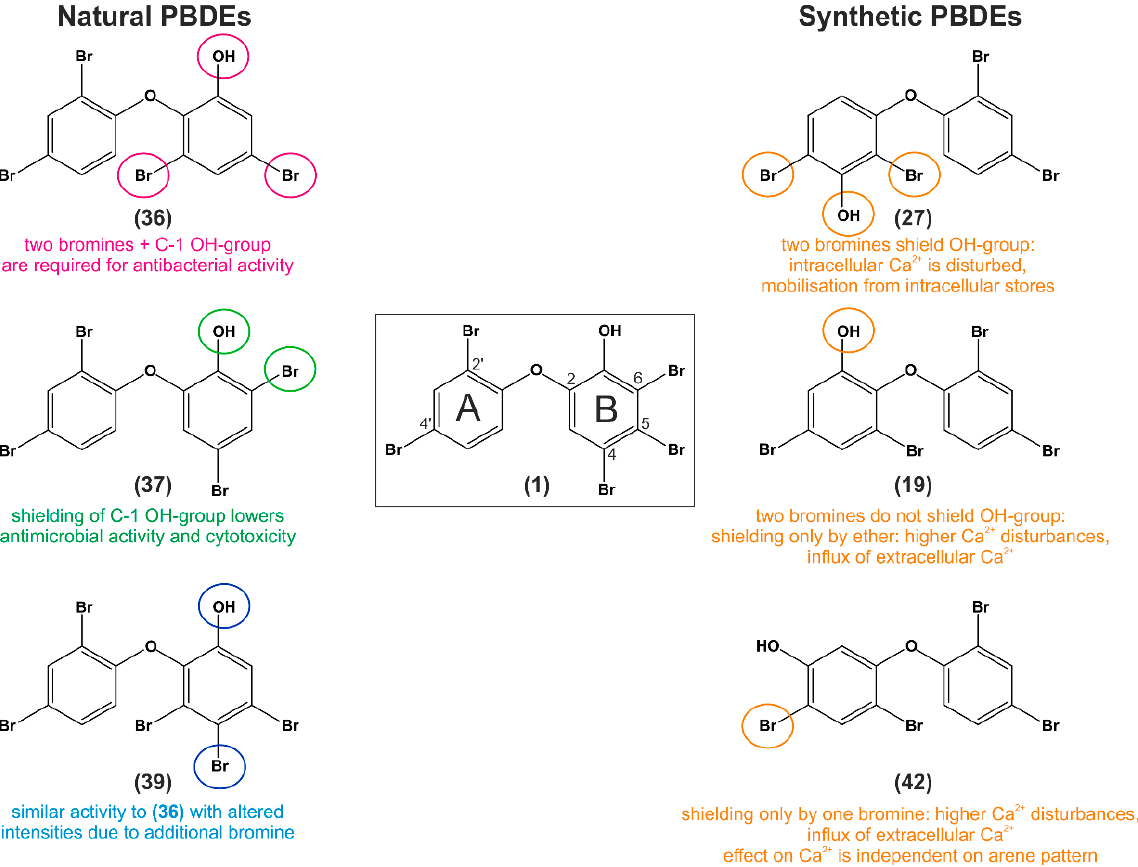
Figure 10. Selected natural [ (36 ), ( 37 ), ( 39 )] and synthetic [( 27 ), ( 19 ), ( 42 )] PBDEs for the structure–activity relationship analysis compared to P01F08. Each, three natural and three synthetic compounds were chosen on equal position and number of bromine substituents at the A-ring, equal position of the ether connecting ring A and B, equal position of phenol-group at B-ring, and at least two bromine substituents have to be at the same position at the B ring similar to P01F08. For each compound, the published SAR conclusions of the corresponding literature source have been added. When investigating natural PBDEs, the researcher focused on the number of bromines and position of OH-group with their influence on bioactivity, respectively (shown in pink for ( 36 ), green for ( 37 ) and blue for ( 39 )). With investigating synthetic PBDEs, we selected SAR conclusions from Dingemans et al. [80,84,85,89] and highlighted the corresponding substituents mediating different bioactivities in orange for ( 27 ), ( 19 ), and ( 42 ). For detailed description of the experimental setups used in the literature, refer to the